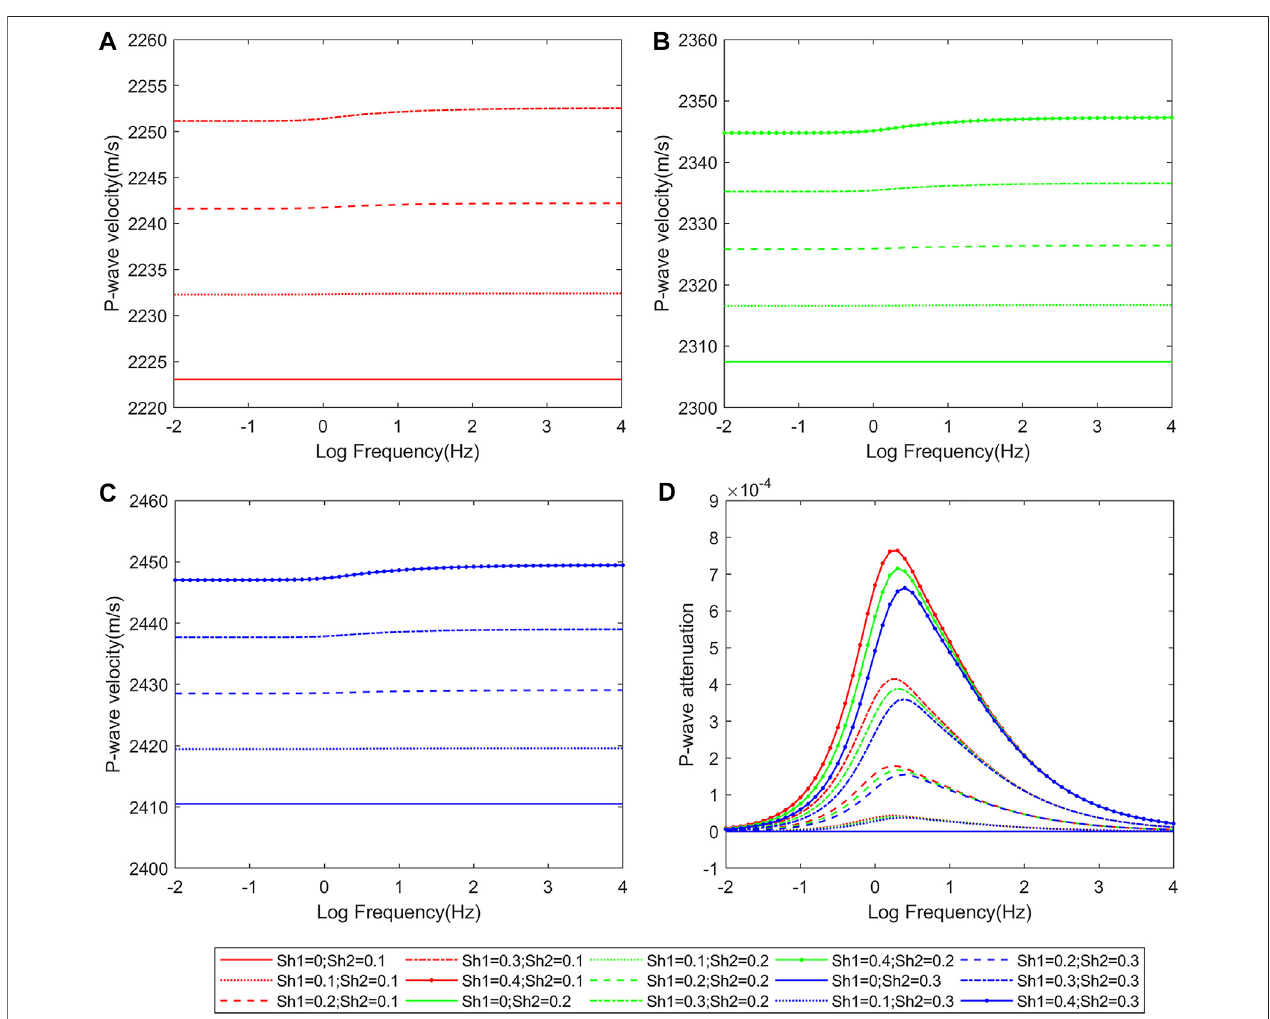
FIGURE 3 | P-wave velocity (A-C) and P-wave attenuation (D) vs. frequency curves at different hydrate contents in mode B.